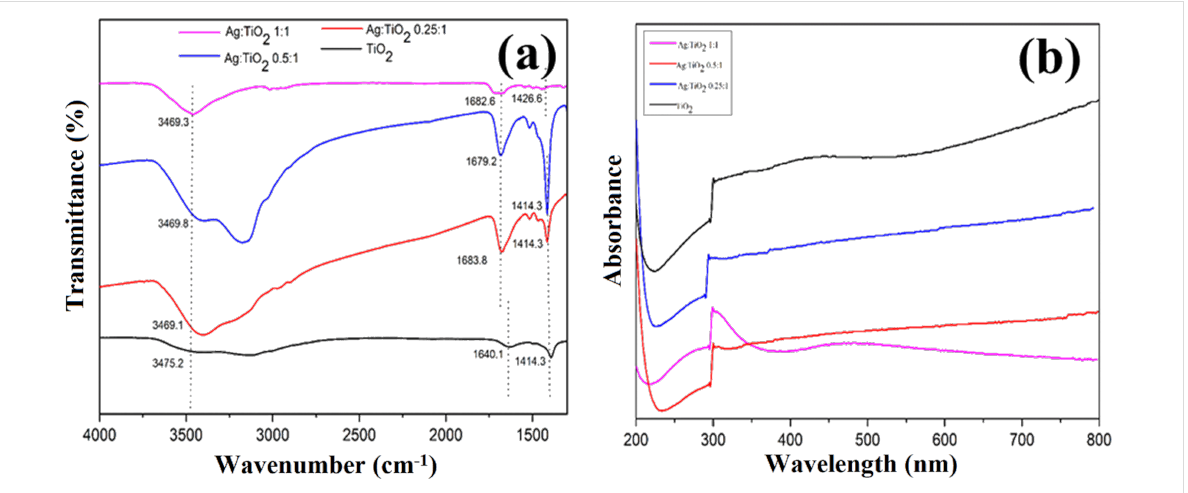
Figure 3: FTIR and UV–vis spectroscopy spectra of the pure TiO 2 NPs and Ag–TiO 2